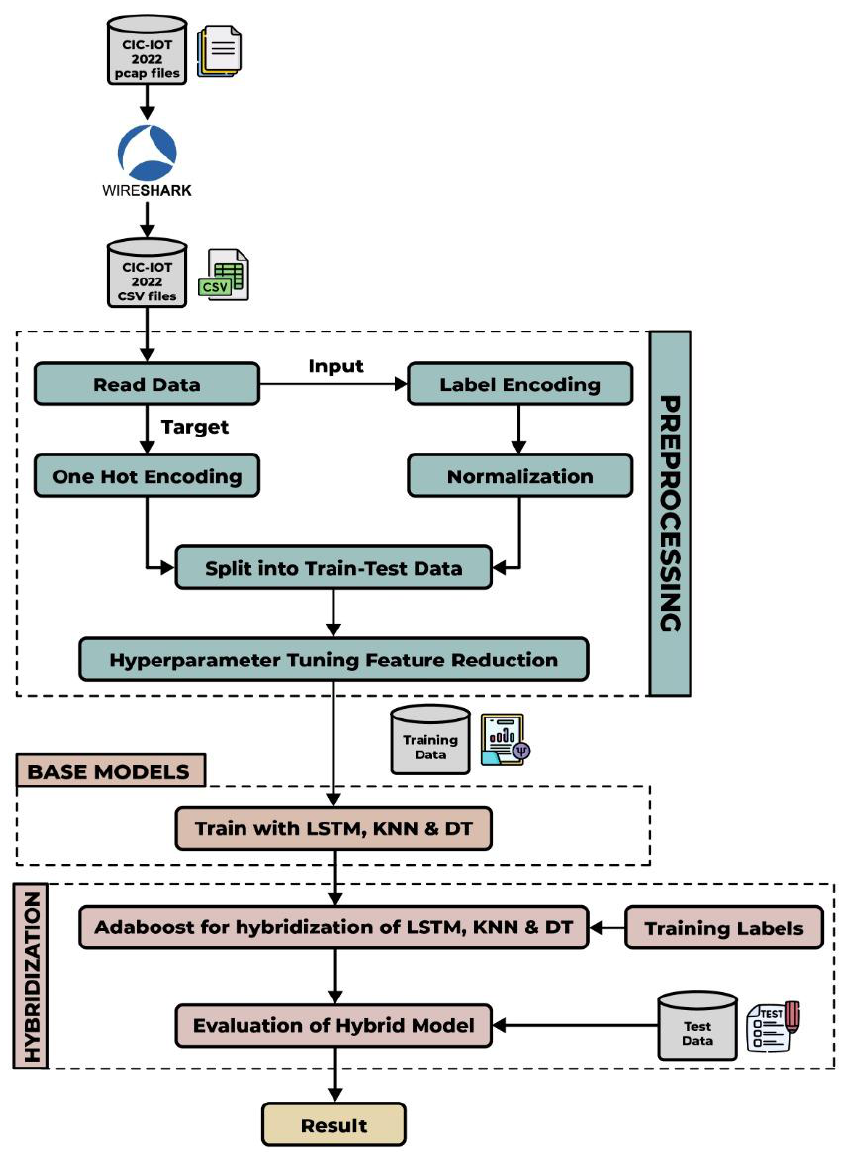
Figure 4. Experimental setup for hybrid KNN, LSTM, and DT.